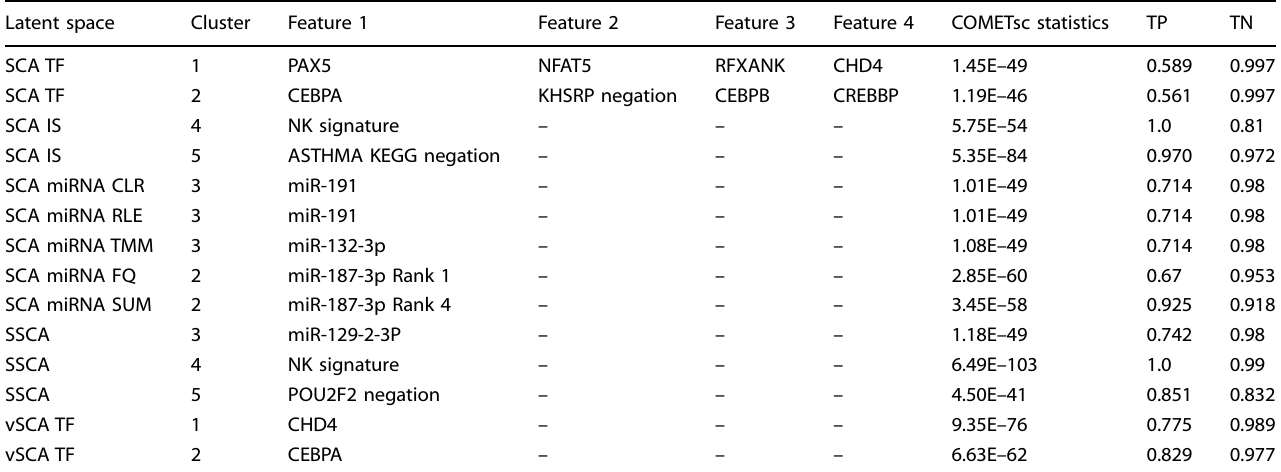
Table 1. Top ranked cluster-speci fi c features detected by the analysis of the latent space using COMET